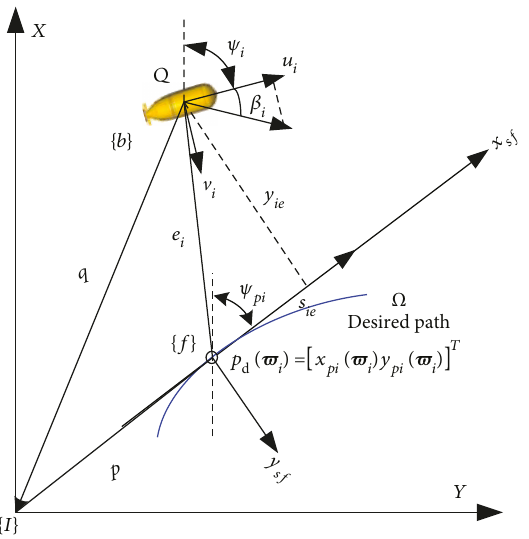
Figure 1: Path-following frames and error